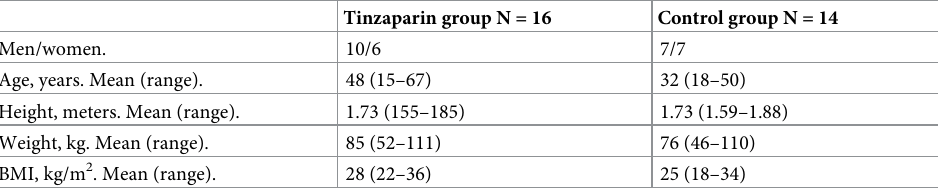
Tinzaparin group N = 16 Control group N = 14